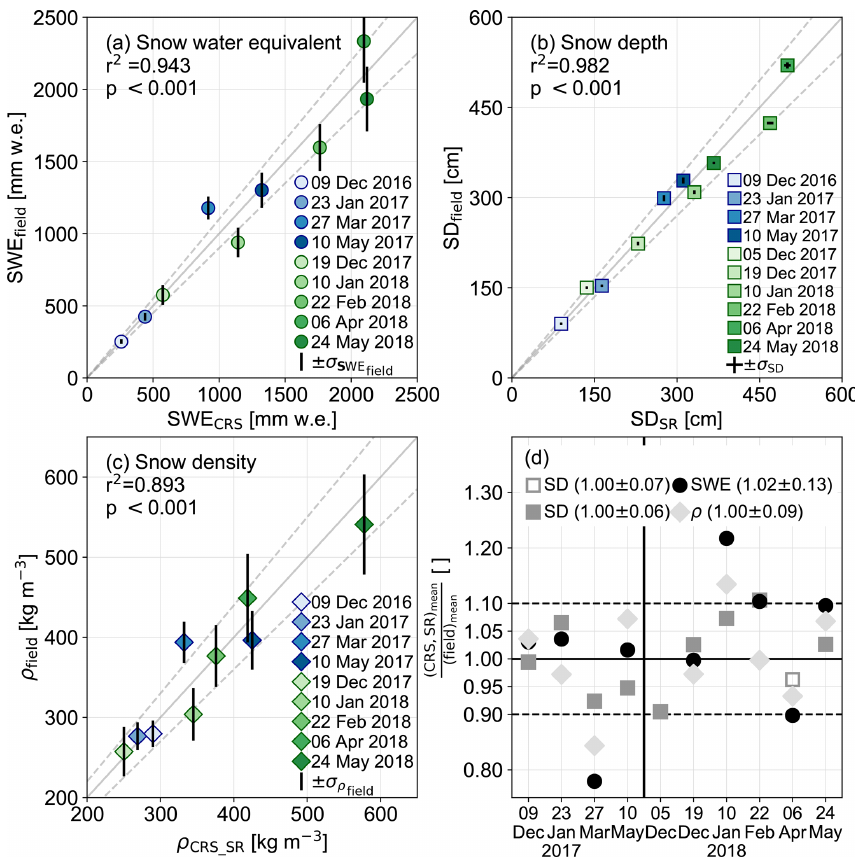
Figure 6. Scatter plots of the field data compared to the autonomous measurements of (a) SWE, (b) SD and (c) bulk snow density. The dashed grey lines show the range within ± 10%. The error bars correspond to the uncertainty of the field data only for SWE and snow density. Panel (d) shows the ratio between automatic and field measurements for SD, SWE and snow density ( ρ ). The unfilled grey squares represent the data interpolated from another station. Table 6. Overview of all considered processes, their criteria and the number of days when the criteria are fulfilled. The colors refer to the processes displayed in Fig.